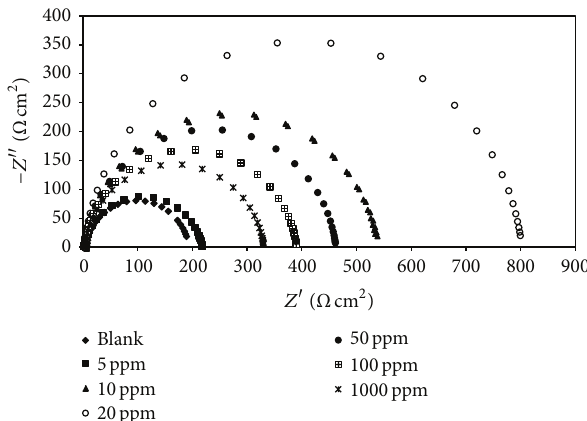
Figure 2: Nyquist plots for composite coatings obtained from plat- ing bath containing different concentration of nano-Al 2 O 3 particles.